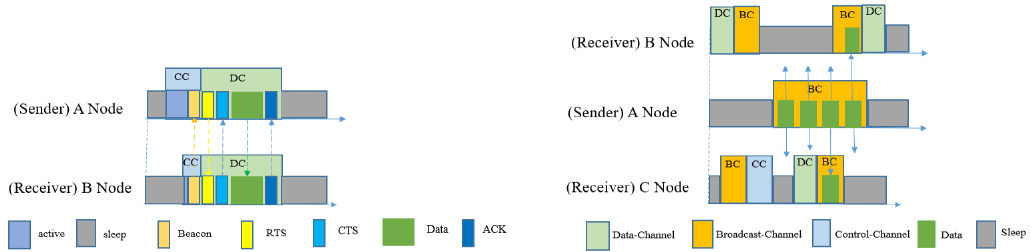
Figure 10. Packet transmission procedure of DCM-MAC in unicast (left) and broadcast (right) scenarios